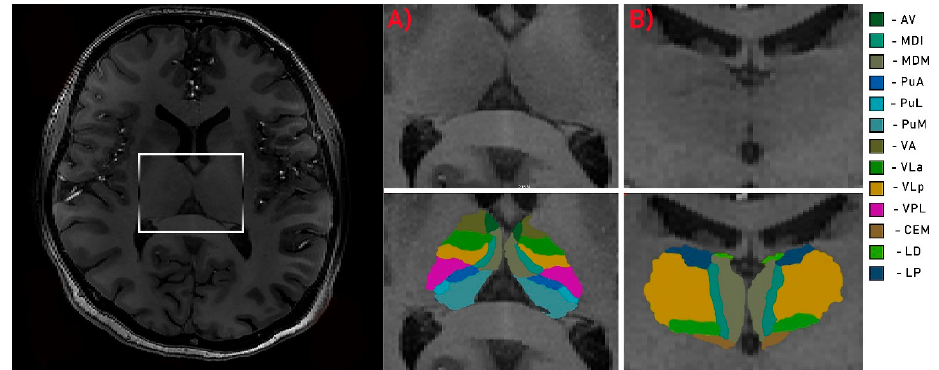
Figure1. Segmentationofthalamus. Axial( A )andcoronal( B )viewsofthethalamus. Av—anteroventral; Figure 1. Segmentation of thalamus. Axial ( A ) and coronal ( B ) views of the thalamus. Av—